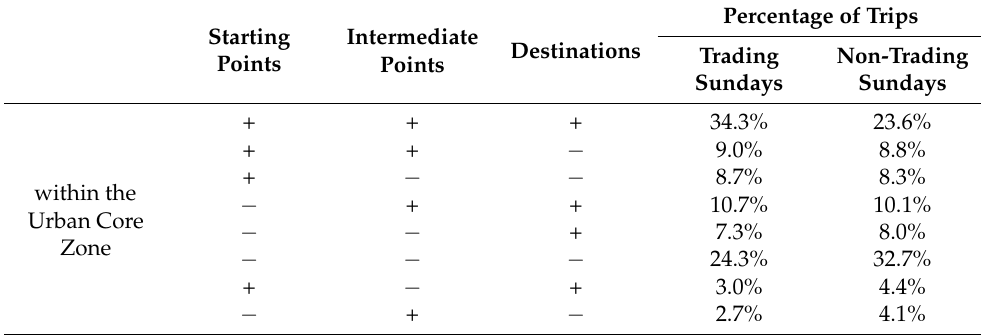
Table 5. The structure of distribution of characteristic points for trips taken by the ŁPB users against the type of land cover in Ł ó d´z in the cycling season of